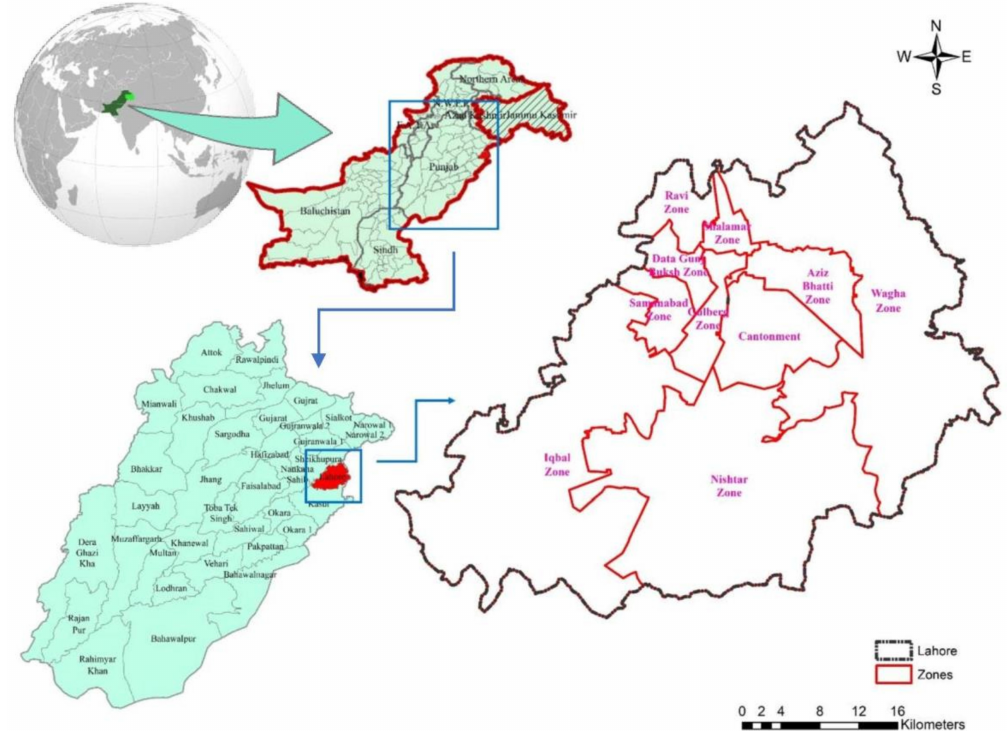
Figure 2. Zone-level administrative map of the city district of Lahore, adapted from